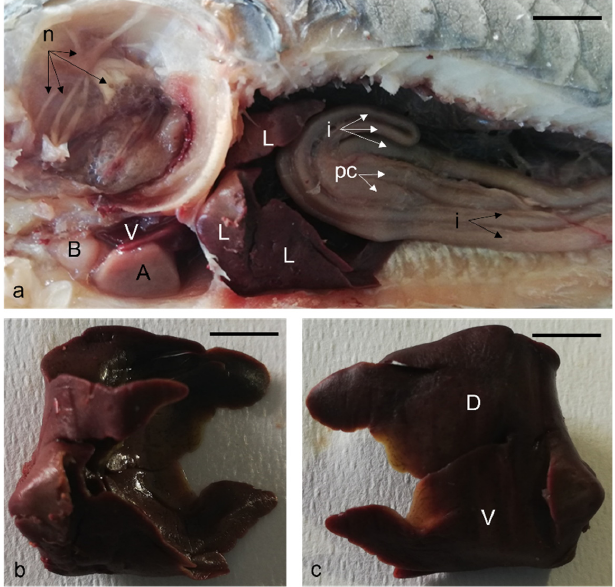
Figure 2. Gross anatomy. ( a ) Photographs of the left side of the celomatic cavity of H. niloticus ; In cranial position: left lobe of the liver (L); pyloric appendages (pc); intestine (i); bulbous (B), atrium (A), ventriculus (V) of the heart; in dorsal position: visible innervation (n) after spiral-shaped apparatus removal. ( b ) Photographs of the liver left side. ( c ) Liver right side: dorsal (D) and ventral (V) lobes. Scale bar: 1 cm.